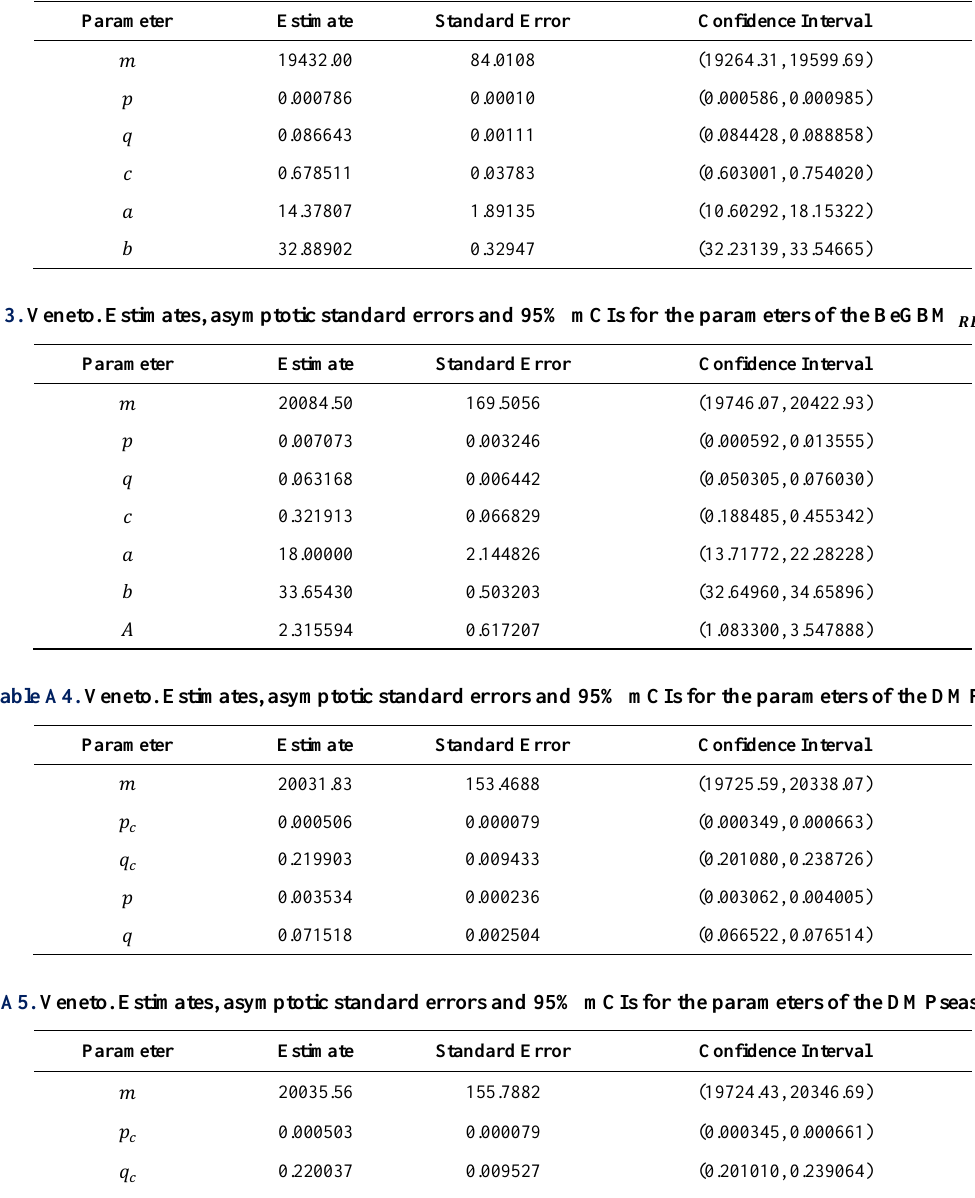
Table A2. Veneto. Estimates, asymptotic standard errors and 95% mCIs for the parameters of the GBM 𝑹𝑬𝑪𝑻 (4)+(5).